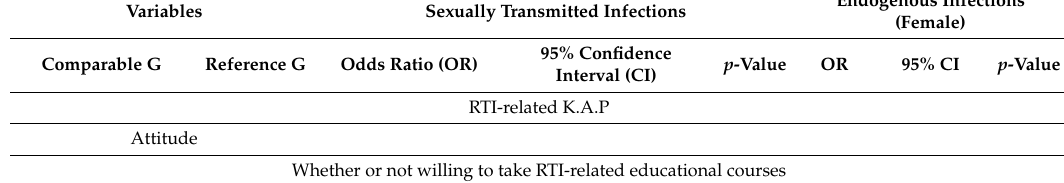
Table 6. Multivariable analyses of the correlation between RTI-related K.A.P and prevalence of RTIs among the internal migrant